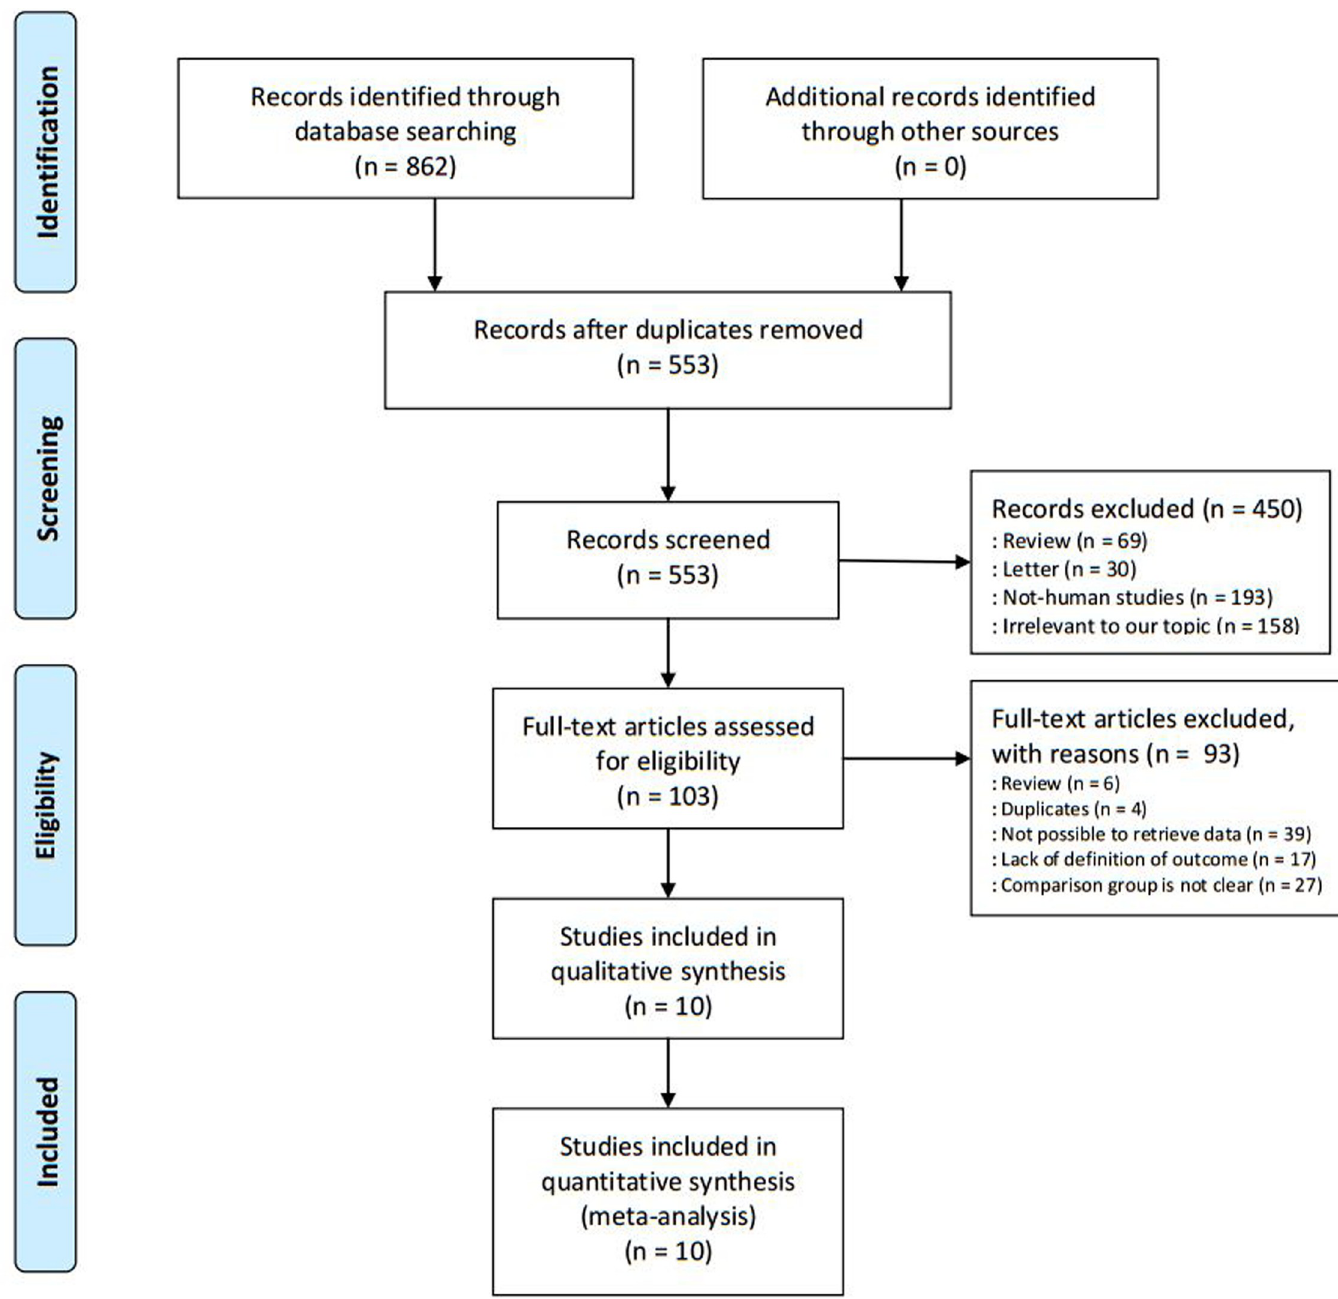
Fig 1. Flow chart for search and selection of studies for inclusion in this